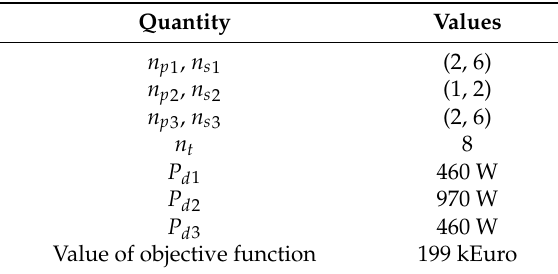
Table 4. Results of the optimization procedure.